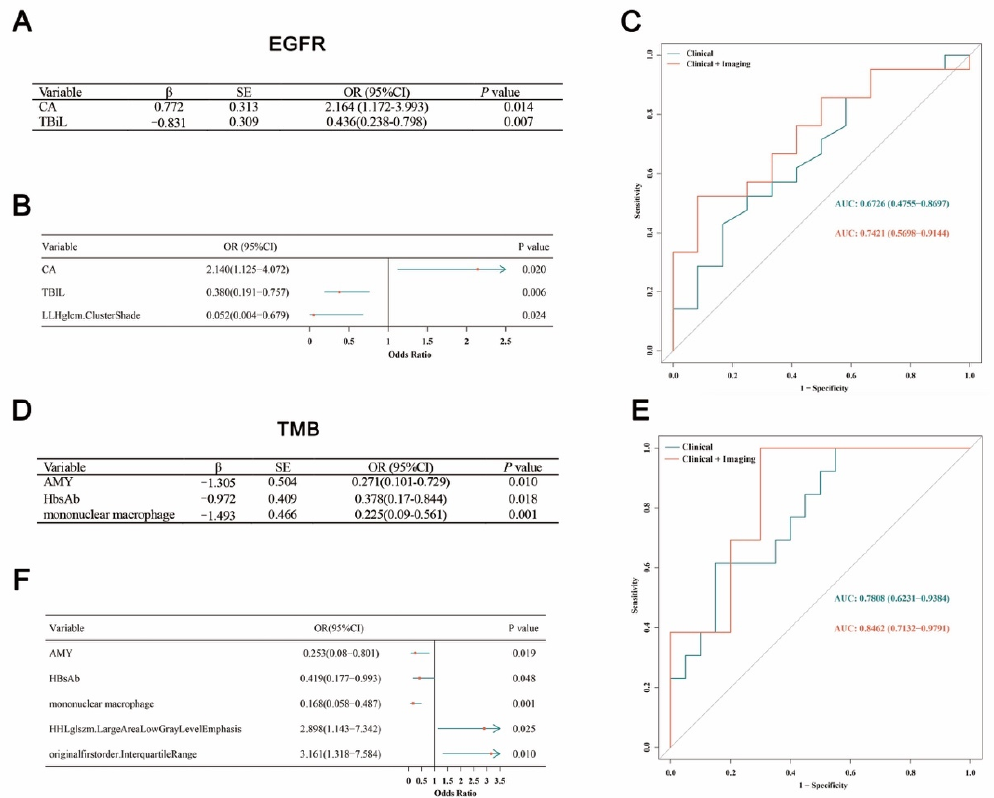
Figure 3. Selected variables information and prediction performance for the EGFR mutations and TMB status integrated model. ( A , D ) show selected variables of EGFR mutations and TMB status model. ( B , E ) show forest plots of selected variables of EGFR mutations and TMB status model. ( C , F ) show ROC of EGFR mutations and TMB status